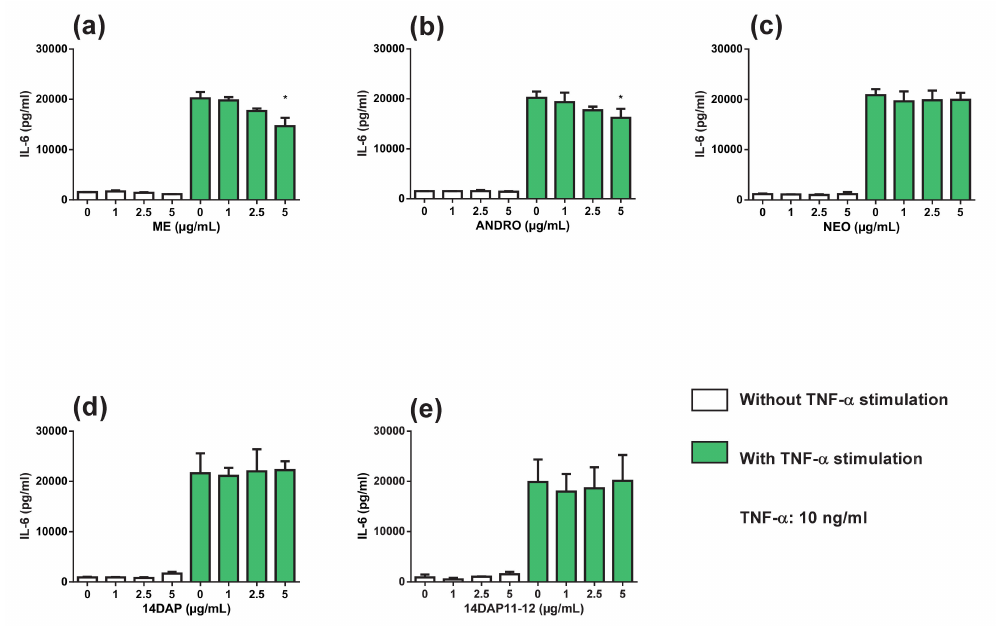
Figure 6. E ff ect of ME, ANDRO, NEO, 14DAP, and 14DAP11-12 on IL-6 secretion. HDFa were treated with increasing concentration (1, 2.5 or 5 µ g / mL) of ME ( a ), ANDRO ( b ), NEO ( c ) 14DAP ( d ), or 14DAP11-12 ( e ) for 24 h. The control cells were treated with 0.05% DMSO. Inflammation was induced by TNF- α (10 ng / mL) and cytokine secretion was done using an ELISA assay. The values mean ± S.D. * p < 0.05 compared with control group, n = 3.